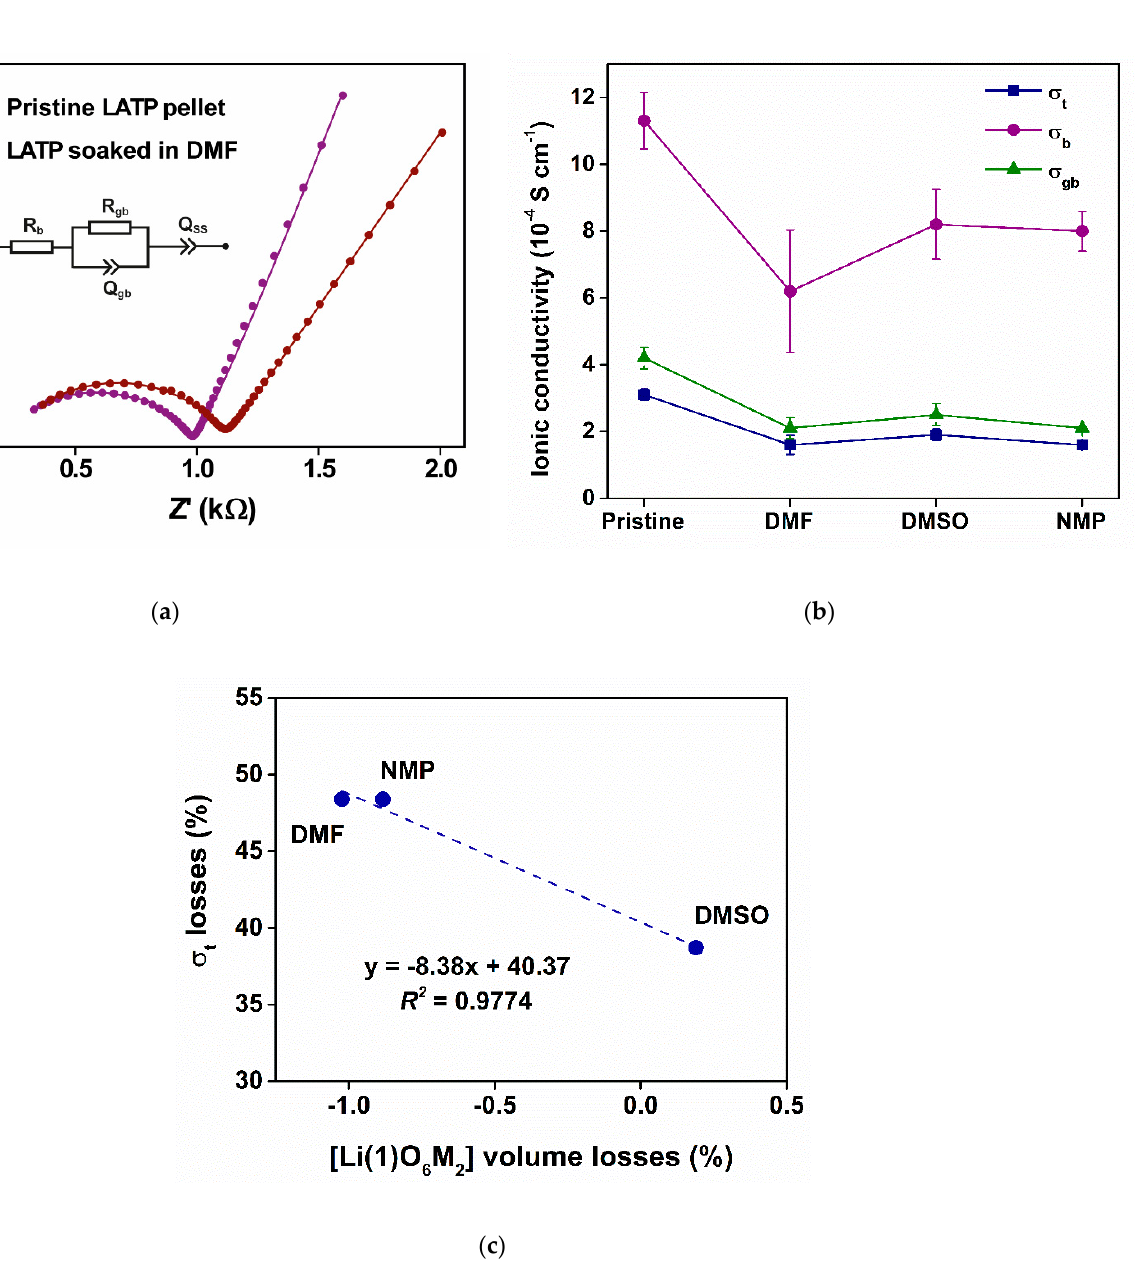
Figure 4. ( a ) Example Nyquist plots of as-synthesized LATP ceramic and LATP after soaking in DMF, dots relate to experimental data and lines − to the fitting curves, inset − for which an equivalent circuit used for the approximation; ( b ) total ( σ t ), bulk ( σ b ), and grain boundary ( σ gb ) IC values of pristine LATP and that after soaking in DMF, DMSO, or NMP; ( c ) correlation between volume of [Li(1)O 6 M 2 ] intrastructural polyhedron and σ t of LATP ceramic.